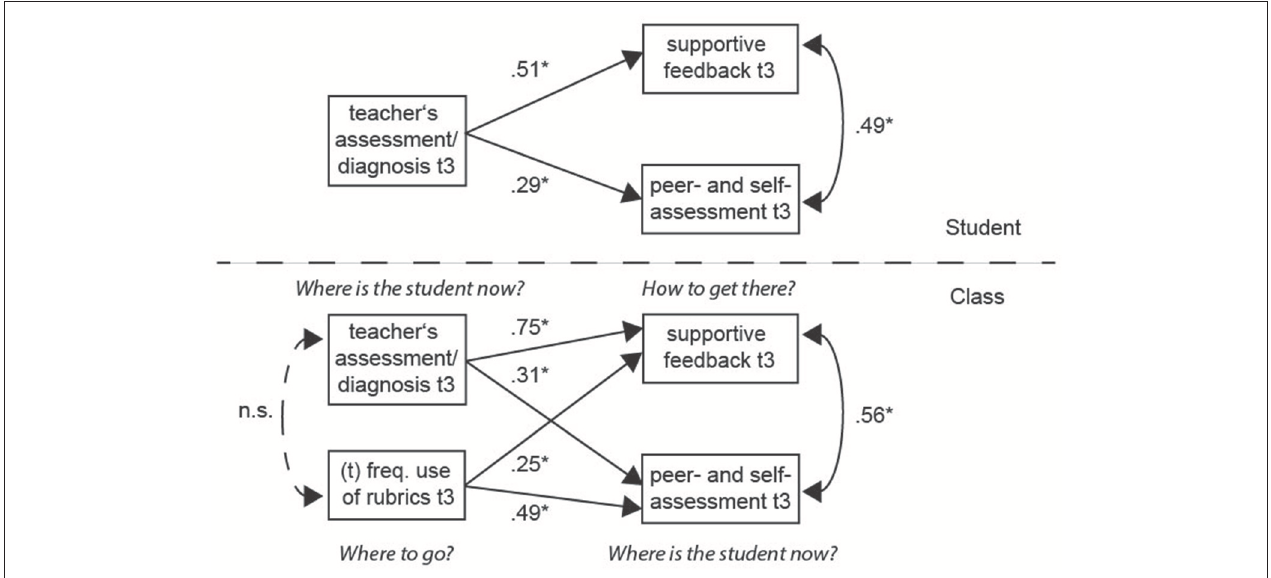
FIGURE 2 | Standardized coefficients for the multilevel model of students’ perceptions related to formative assessment and the teachers’ use of rubrics. N between = 42, N within = 677; * p < 0.05; (t) = item of teacher